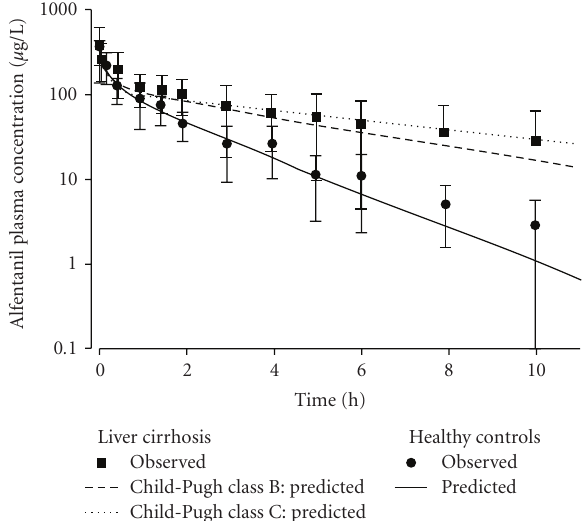
Figure 3: Predicted and observed arithmetic mean ( ± SD) plasma concentration-time curves of alfentanil in (a) healthy controls and (b), (c) patients with liver cirrhosis. Figure is adapted from Edginton and Willmann